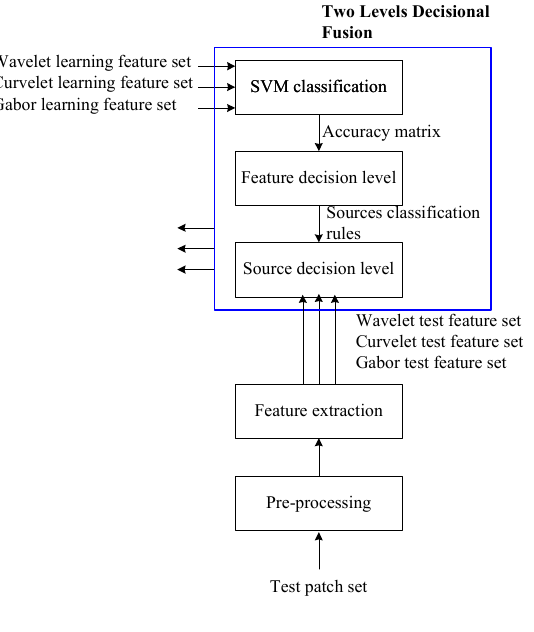
Figure 2. Two levels decisional